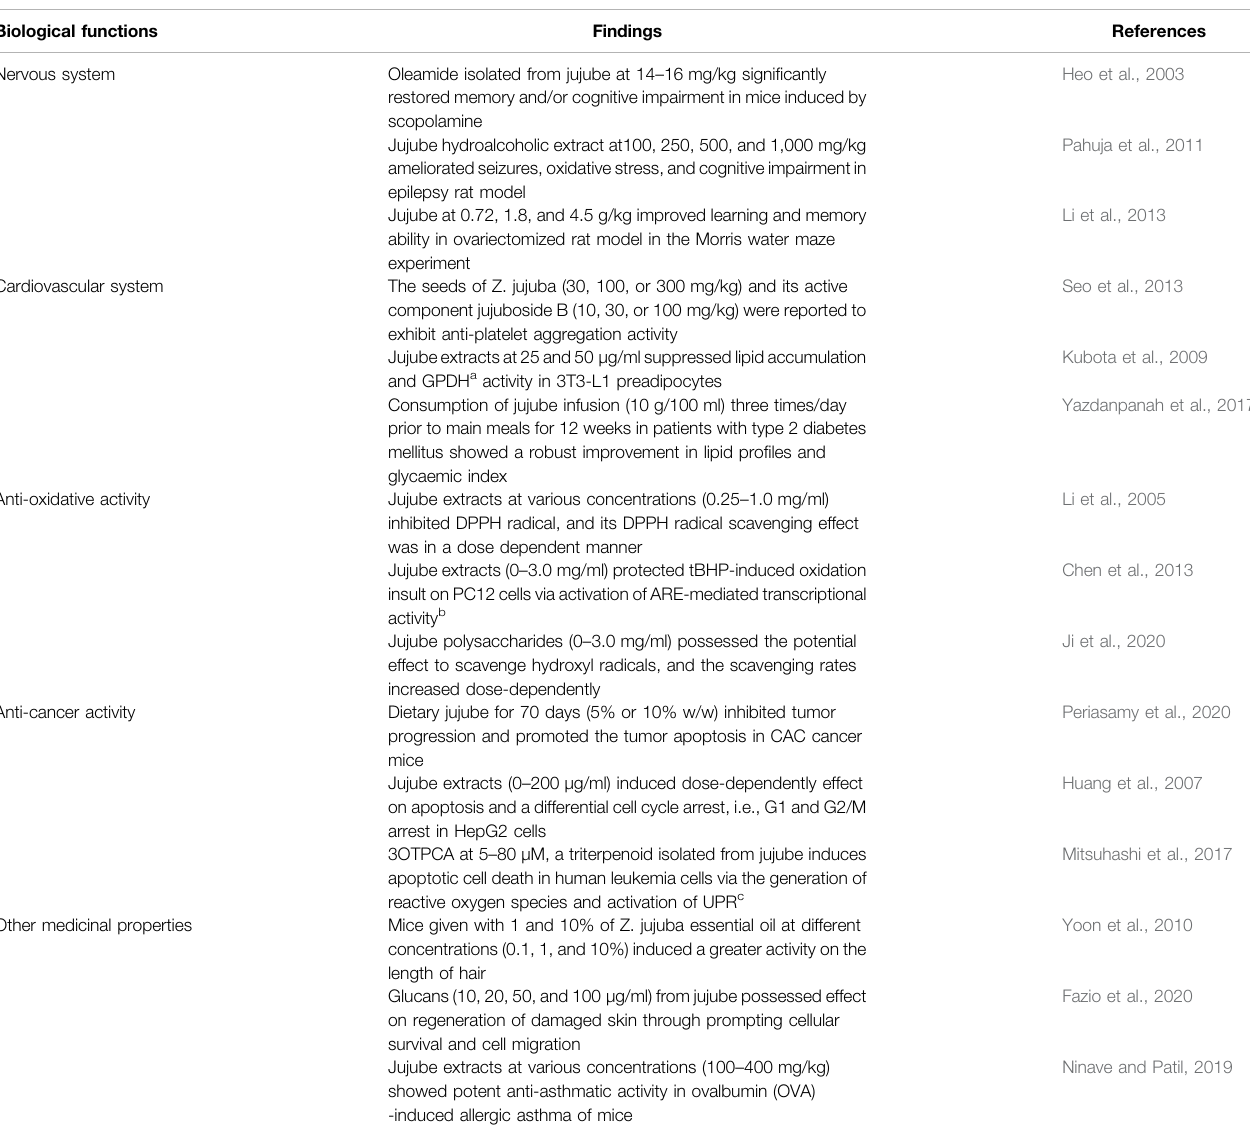
TABLE 1 | Health bene fi cial properties of